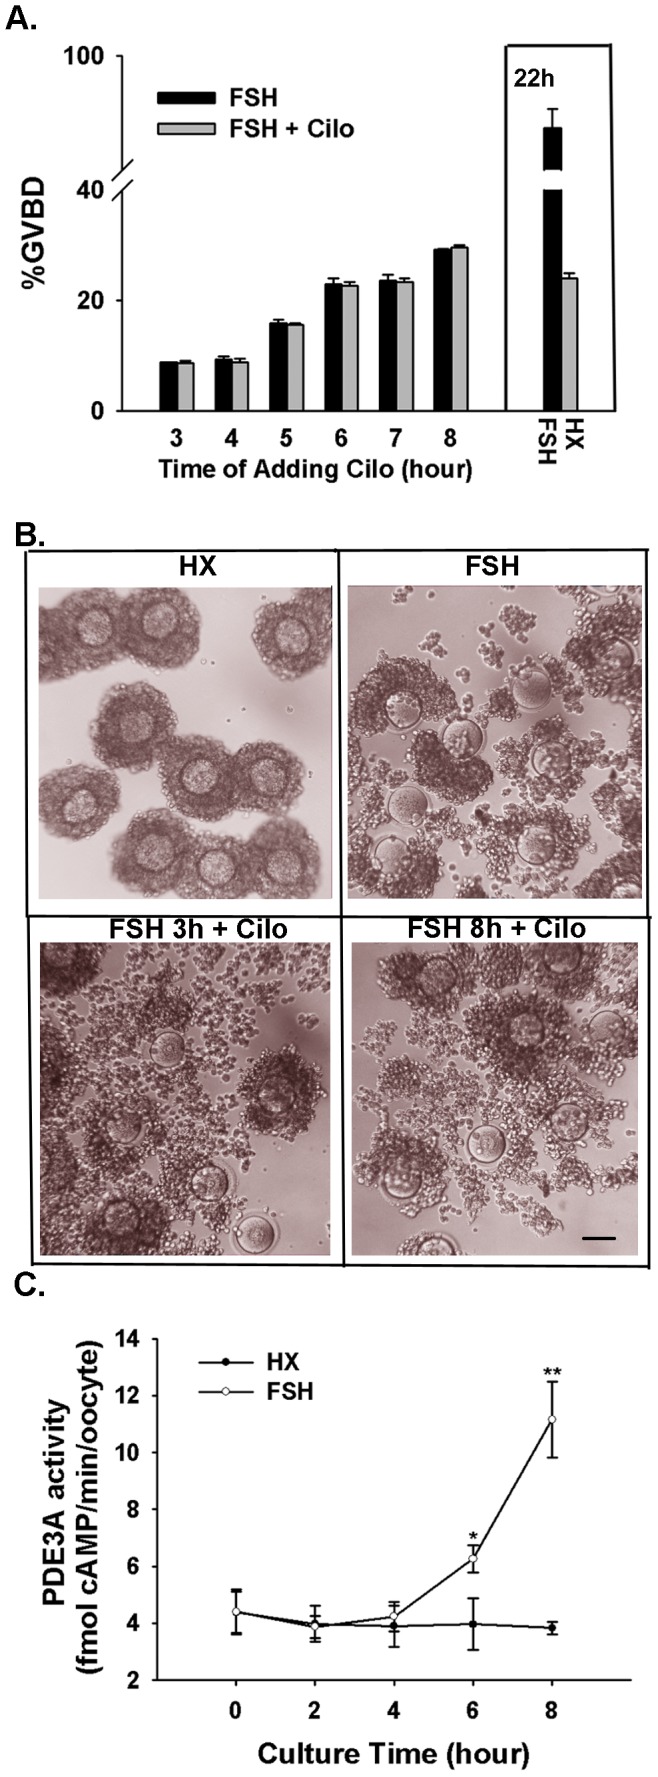
Correlations between FSH and PDE3A.(A) Inhibiting PDE3A blocked the effect of FSH on maturation. COCs were cultured in HX medium containing 50 IU/L FSH. Cilostamide (cilo) was added to one set of cultures 3, 4, 5, 6, 7, or 8 h after the start of culture. GVBD was assessed at 22 h (gray bars). The other set of cultures was examined at different intervals up to 8 h (black bars). Cilostamide blocked further meiotic maturation at each time point at which it was administered. GVBD percentage of the controls is indicated by the box. (B) Inhibiting PDE3A didn't affect cumulus expansion induced by FSH. Cumulus expansion was detected at the end of 22 h culture. HX, control; FSH, 50 IU/L FSH; FSH 3 h+Cilo, Cilostamide (cilo) was added to culture 3 h after the start of FSH treatment. FSH 8 h+Cilo, Cilostamide (cilo) was added to culture 8 h after the start of FSH treatment. Scale bar, approximately 50 µm. (C) After stimulation with FSH for 6 h, oocyte PDE3A activity significantly increased. Means marked with asterisks are significantly different (*P<0.05, **P<0.01).